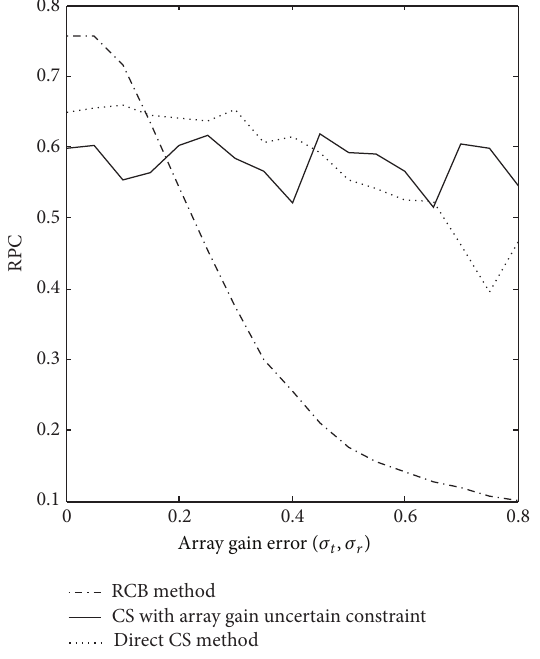
Figure 4: Comparison of the performance of sparse recovery method with the